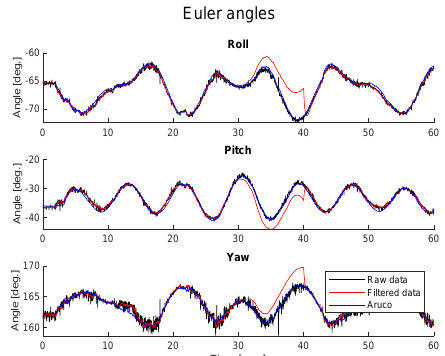
Figure 13: Estimated roll-pitch-yaw angles when the vanishing point detector is unavailable from 30 s to 40 s. It is seen that the angles drift off in the interval.